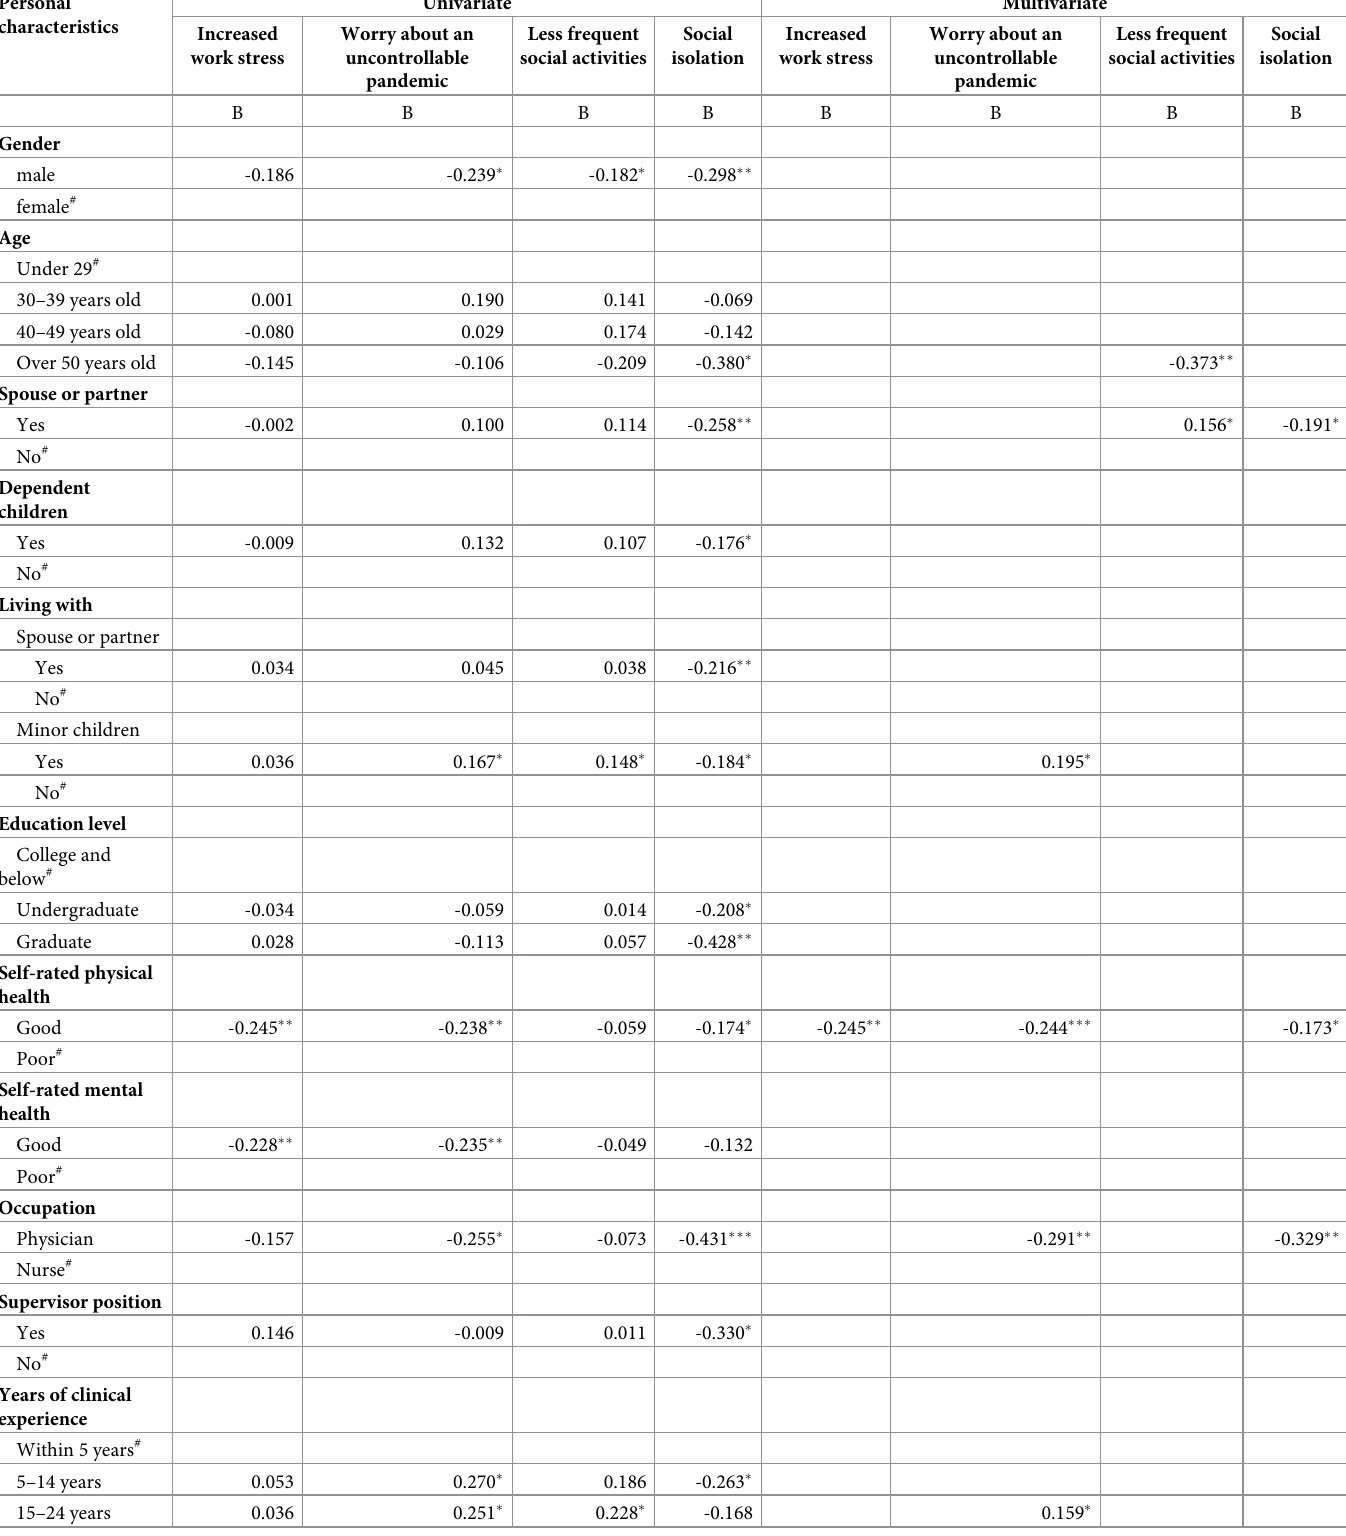
Table 3. Univariate and multivariate stepwise regression analysis of perceived impact of covid-19 related